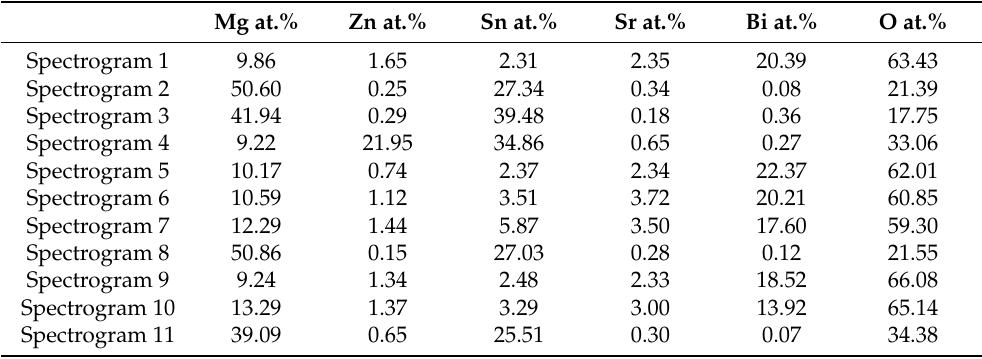
Table 1. SEM energy spectrum analysis results.